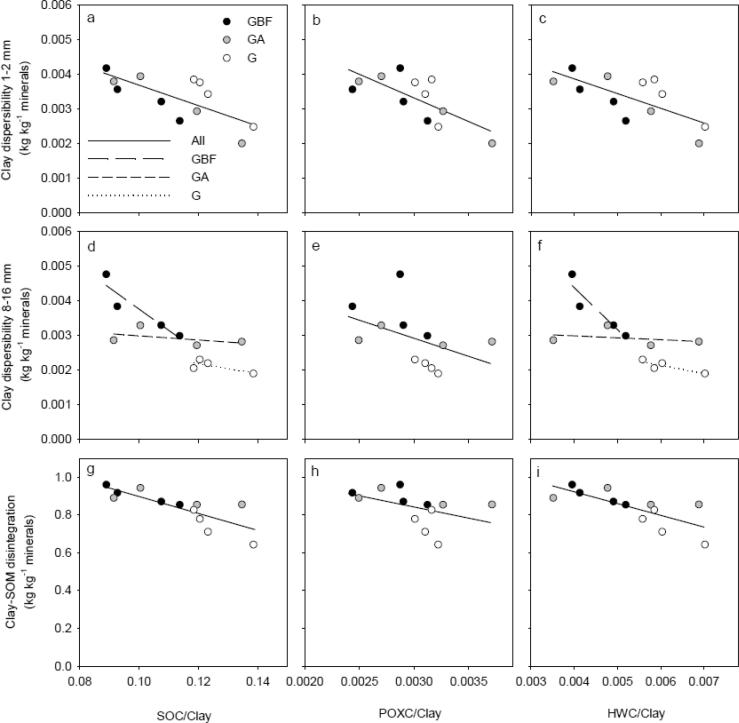
Correlations between soil structural stability measures and clay-content normalized expressions of soil organic carbon (SOC/Clay), permanganate oxidizable carbon (POXC/Clay) and hot water-extractable carbon (HWC/Clay) for GBF, GA and G at plot level. White, gray and black symbol fills highlight treatments grass, arable and bare fallow, respectively, at time of sampling. The linear regression including data for all treatments are indicated if the slope of linear regressions for individual treatments were not significantly different, whereas the linear regression for individual treatments are shown if the slope of the regressions were significantly different. See Table 2 for slopes, differences between slopes, and R2- and P-values. For treatment abbreviations, see Fig. 1.